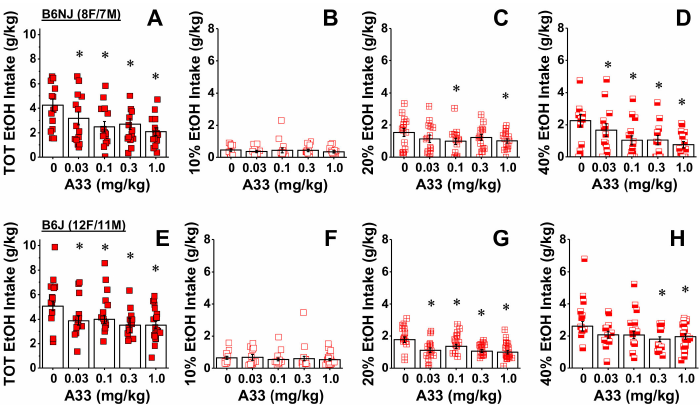
Figure 3. A33 reduces binge alcohol intake in both B6NJ and B6J mice. Summary of the dose–response function for A33-induced reduction in ( A ) total alcohol (EtOH) intake and ( B – D ) intake from the sipper tubes containing, respectively, 10%, 20% and 40% alcohol in female and male B6NJ mice (8 females/7 males). ( E ) Same as Panel A for female and male B6J mice. ( F – H ) Same as Panels B–D for female and male B6J mice (12 females/11 males). The data represent the mean ± SEM of the number of mice indicated, in addition to the individual data points for each A33 dose. * p < 0.05 vs. 0 mg/kg of A33 (tests for simple main